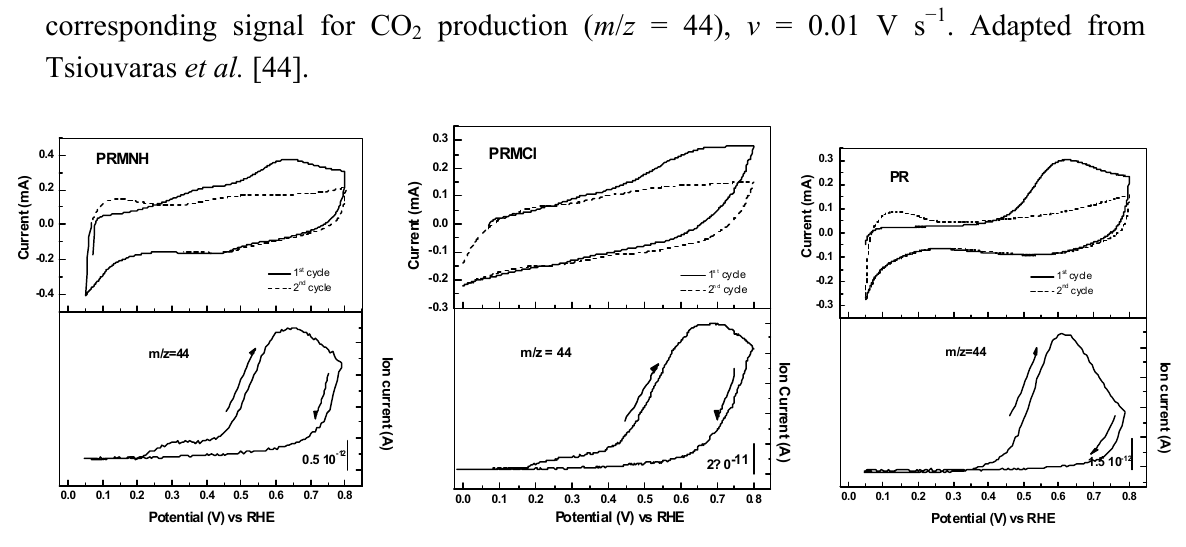
SO at 25 °C of electrocatalysts and the 2 4 production ( m / z = 44), v = 0.01 V s − 1 . Adapted from 2